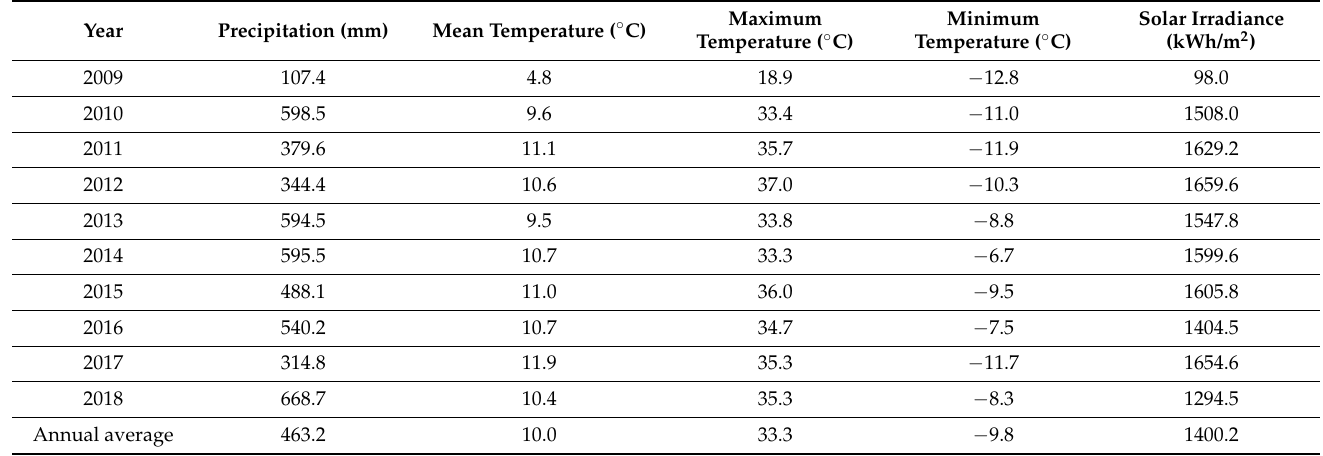
Table A2. Average climatic conditions of the study site located in Spain during the study